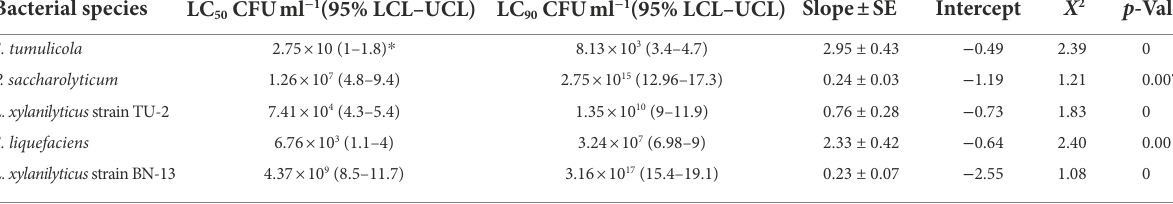
TABLE 3 Aphicidal activity of five bacterial species cells against A. illinoisensis after 48 h of exposure. Bacterial